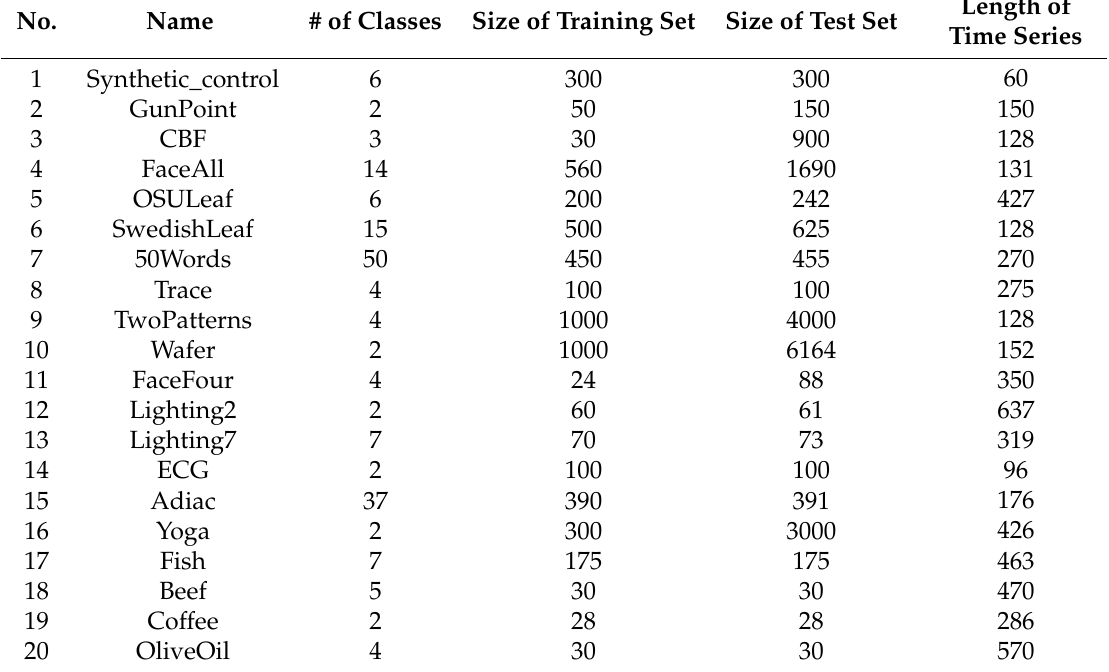
Table 1. The description of twenty UCR